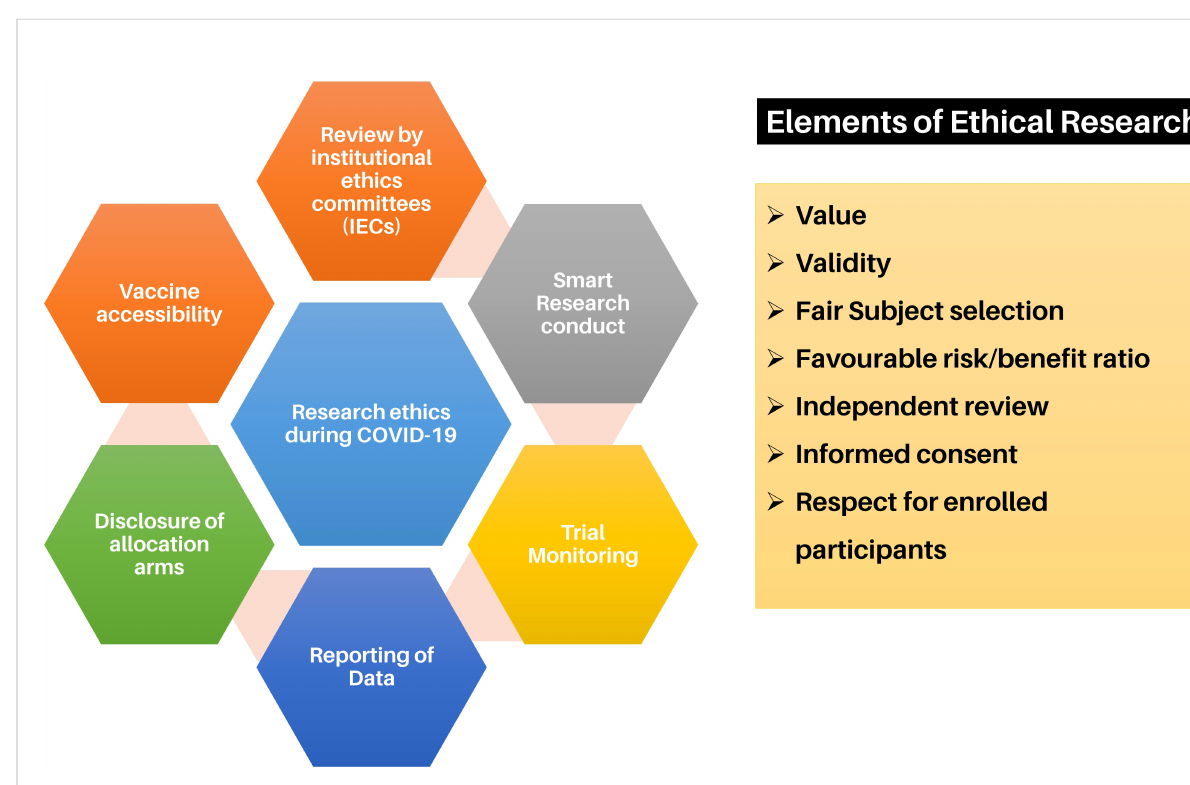
FIGURE 7 Ethical considerations for vaccine research for COVID-19 (162,